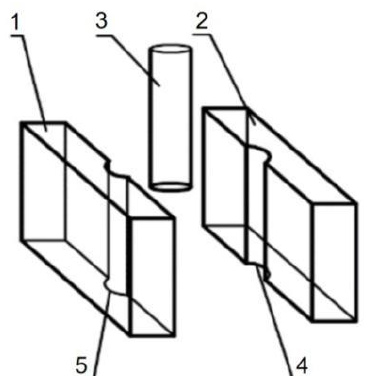
(2) refers to the static friction block, which was fixed on the machine tool and 10 µ m away from the mandrel (3). The cambered surfaces were made on the static friction block (4) and dynamic friction block (5), respectively, each arc angle was 60 ◦ , and the radius of the arcs was the same as the mandrel radius.